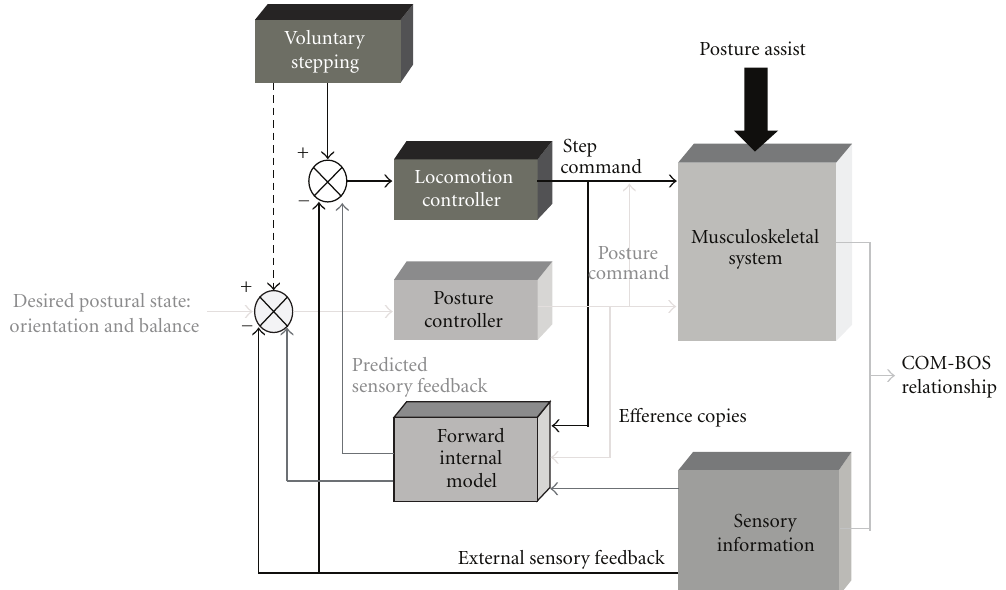
Figure 1: Forward internal model for posture and locomotion coupling during the initiation of gait. To initiate stepping locomotion, posture and locomotion networks are activated in parallel to generate motor commands where the posture network acts on the stepping controller. This motor output modifies the body center of mass-base of support (COM-BOS) relationship. With external posture assistance (e.g., mechanical or sensory simulation of single stance limb loading) that enhances weight transfer to the single stance limb, an e ff erent copy of the motor commands and sensory information about the actual state of the body can be used by the CNS to modify the two commands in advance based on an internal representation of the body and external environment (forward model). Online sensory information can also modulate posture and locomotion via external